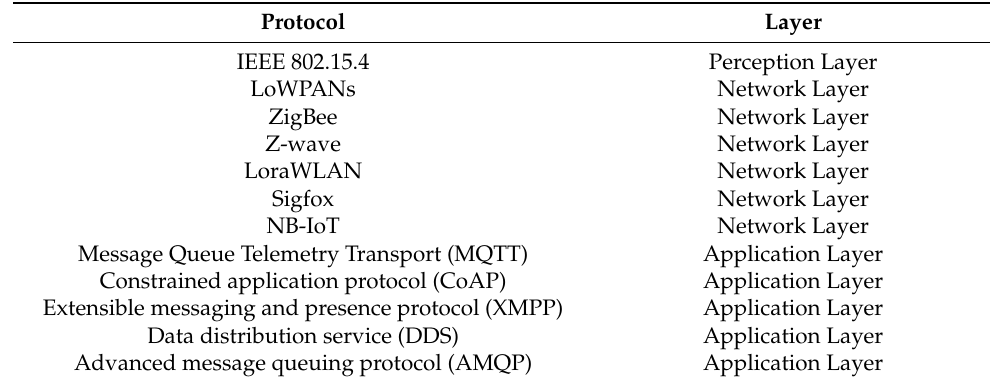
Table 4. Most common protocols in